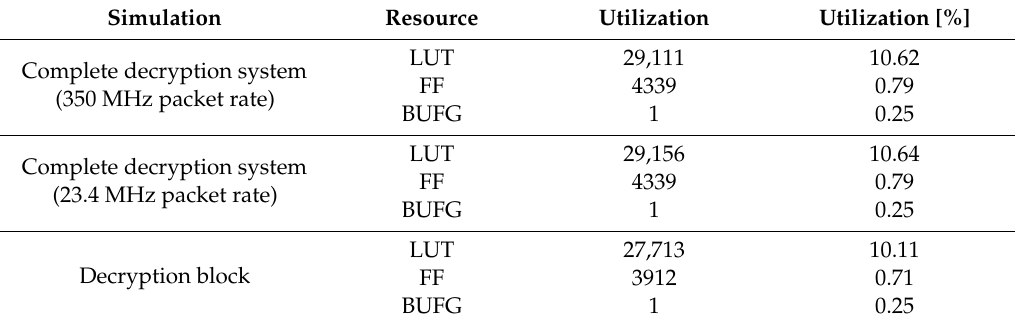
Table 2. Hardware resource utilization related to the complete decryption scheme, including all the blocks to test the decryption algorithm, both when the encrypted packets are received in input on each rising edge of the 350 MHz clock signal and when they are provided every 42.7 ns (i.e., 23.4 MHz); also, the resource utilization of only the decryption block are